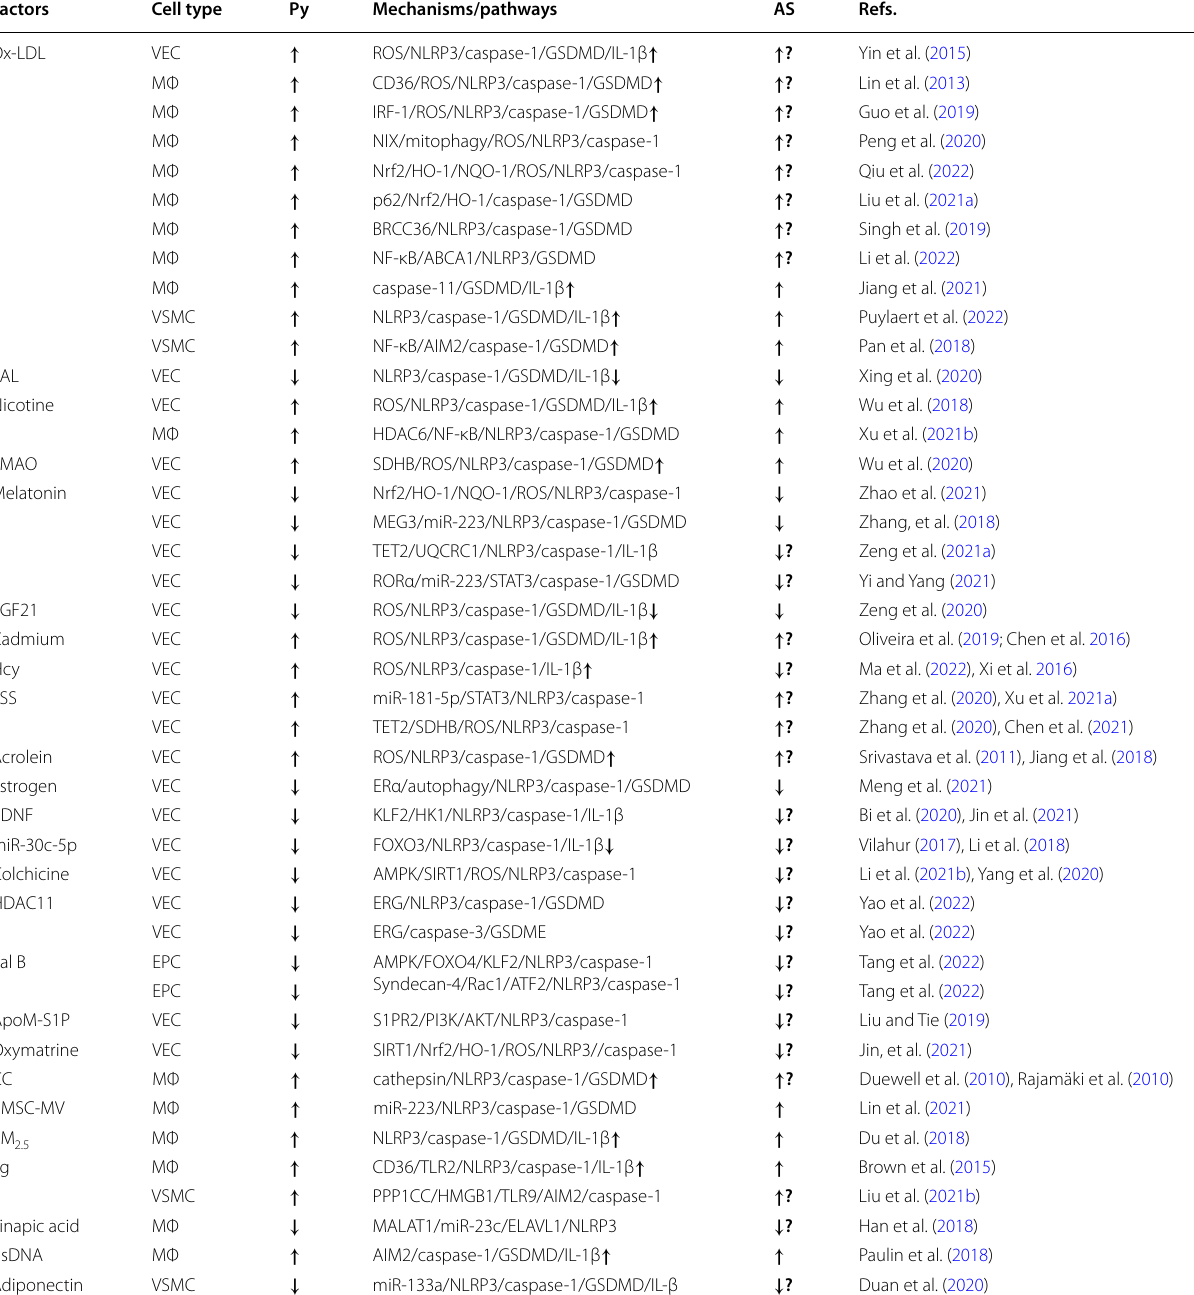
Table 1 Factors that regulate pyroptosis of plaque cells in atherogenesis and the underlying